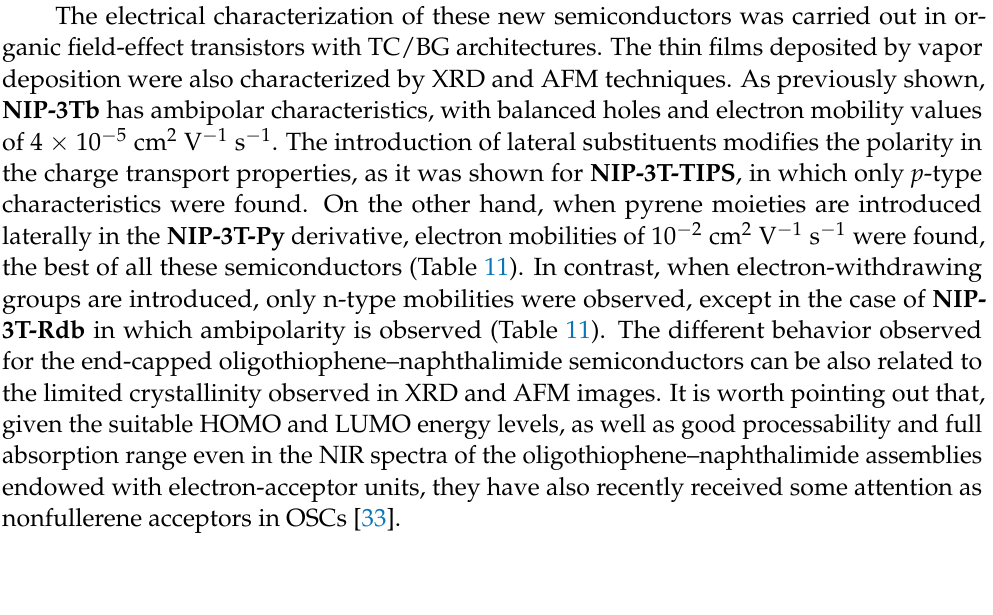
Table 11. OFET electrical data for vapor-deposited films of NIP-3Tb , NIP-3T-DCVb , NIP-3T-Rdb , NIP-3T-Py and NIP-3T-TIPS measured under vacuum on vapor-treated Si/SiO 2 substrates. Aver- age field-effect mobilities are shown a .